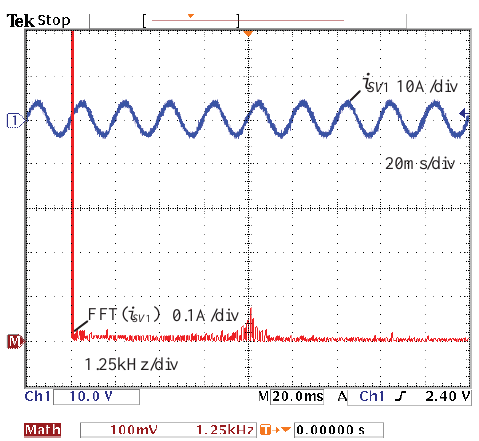
Table 2. Operation conditions of Figure 5.